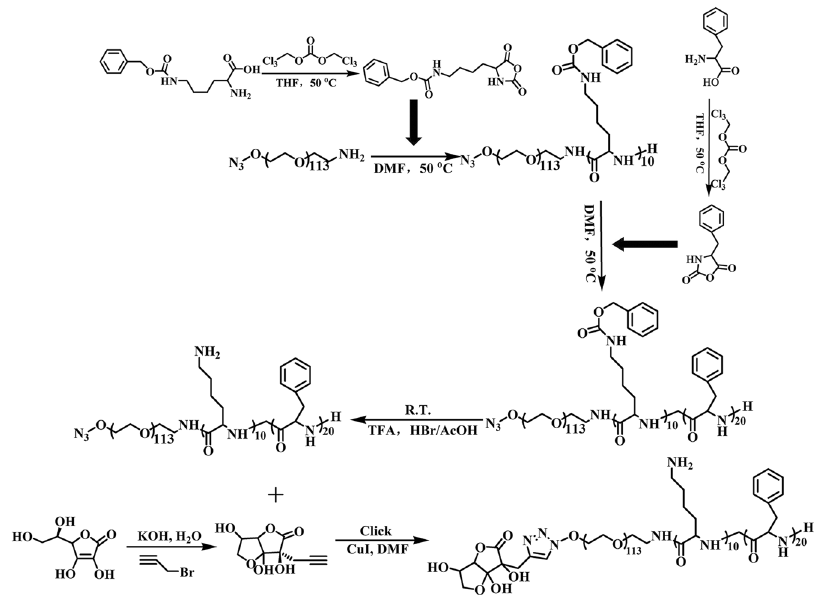
Figure 6. Synthetic route of DHA modified polymeric